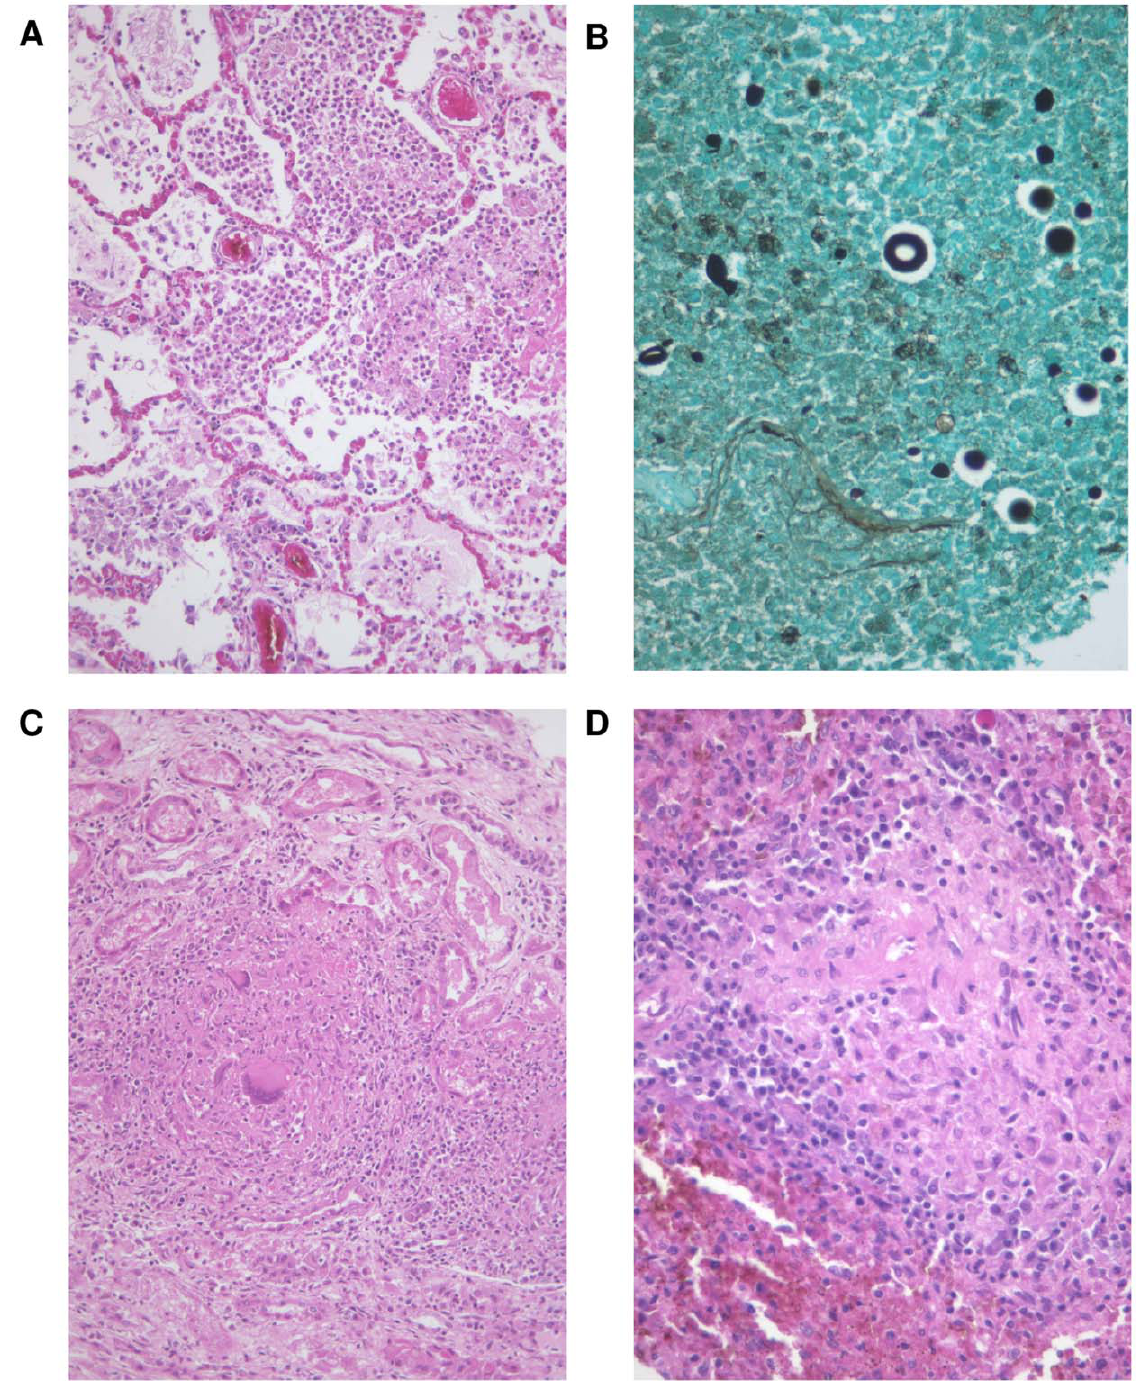
Figure 1. Simultaneous C.neoformans pneumonia and paradoxical M.tuberculosis Immune Reconstitution Inflammatory Syndrome (IRIS). At the time of death, this patient (E33) had been on anti-tuberculosis therapy for pulmonary tuberculosis for 5 months (with good response to treatment) and antiretroviral therapy for 1 month. Histologic sections demonstrate (a) suppurative consolidation of the lungs with (b) cryptococcal organisms apparent on Grocott’s Methanamine Silver (GMS) stain. Kidney (c) and spleen (d) demonstrate well formed necrotizing granulomatous inflammation, with negative Ziehl-Neelsen and GMS stains for organisms; these were thought to represent an exuberant inflammatory response due to paradoxical TB IRIS. doi:10.1371/journal.pone.0047542.g001 impact of IRIS due to miscategorization of overwhelming might have more accurately made this distinction. We did not do infections as unmasking IRIS; use of a prospective study design mycobacterial drug-susceptibility testing which would also have with serial measurements of CD4 cell count and HIV viral load helped clarify whether deteriorations after ART were due to IRIS